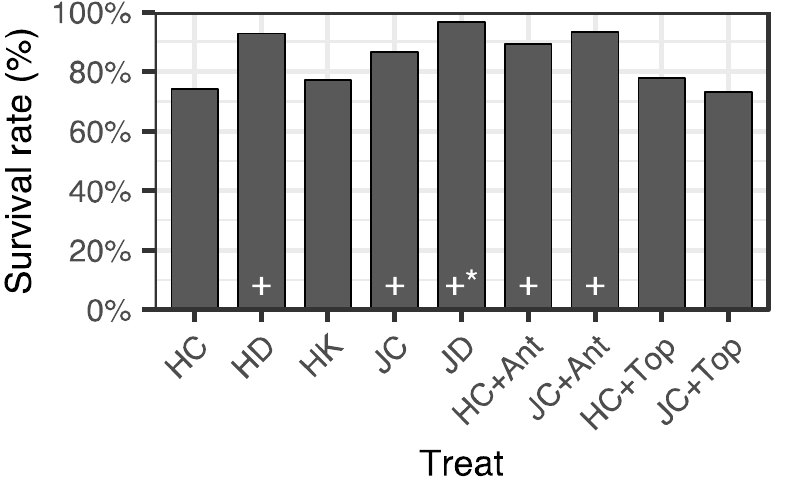
Figure 3. Survival of container seedlings ( n = 23–30) grown in Hiko-V-120 (H) and JFA-150 (J) containers with control irrigation and fertilization (HC and JC), dry irrigation (HD and JD), high- potassium fertilization (HK), application of antitranspirant (+Ant), and topping (+Top). The plus sign indicates a positive effect compared with the HC treatment in the generalized linear mixed